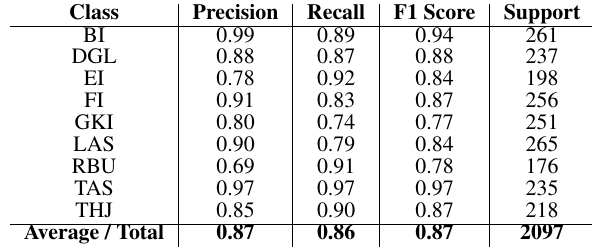
Table 1. Precision, recall and F1 score for each tree species regarding the classification on single box